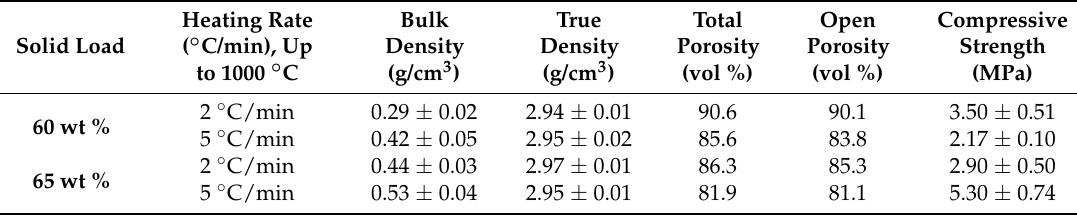
Table 1. Physical and mechanical properties of W-D glass-ceramic foams produced by different solid